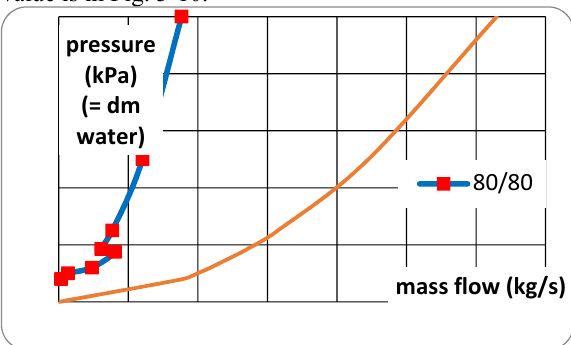
Fig. 3-10. Real (low) mass flow through the simulated valve and ideal (high) mass flow through the simple